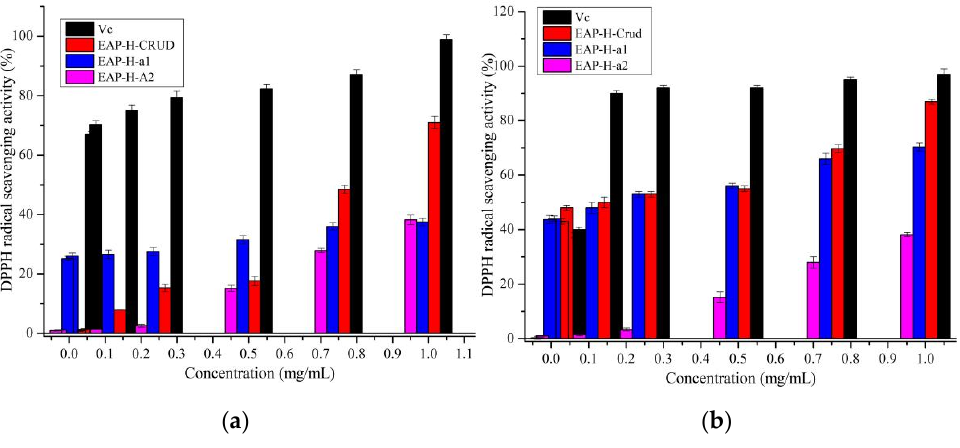
Figure 9. Antioxidant activity of the polysaccharides. ( a ) DPPH; ( b )